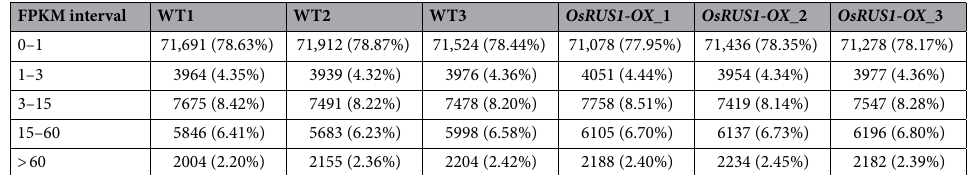
Table 2. Statistics of genes in different expression-level interval. FPKM, expected number of Fragments Per Kilobase of transcript sequence per Million base pairs sequenced. WT, the wildtype of ZhongHua11; OsRUS1-OX , the OsRUS1-GFP Overexpression transgenic